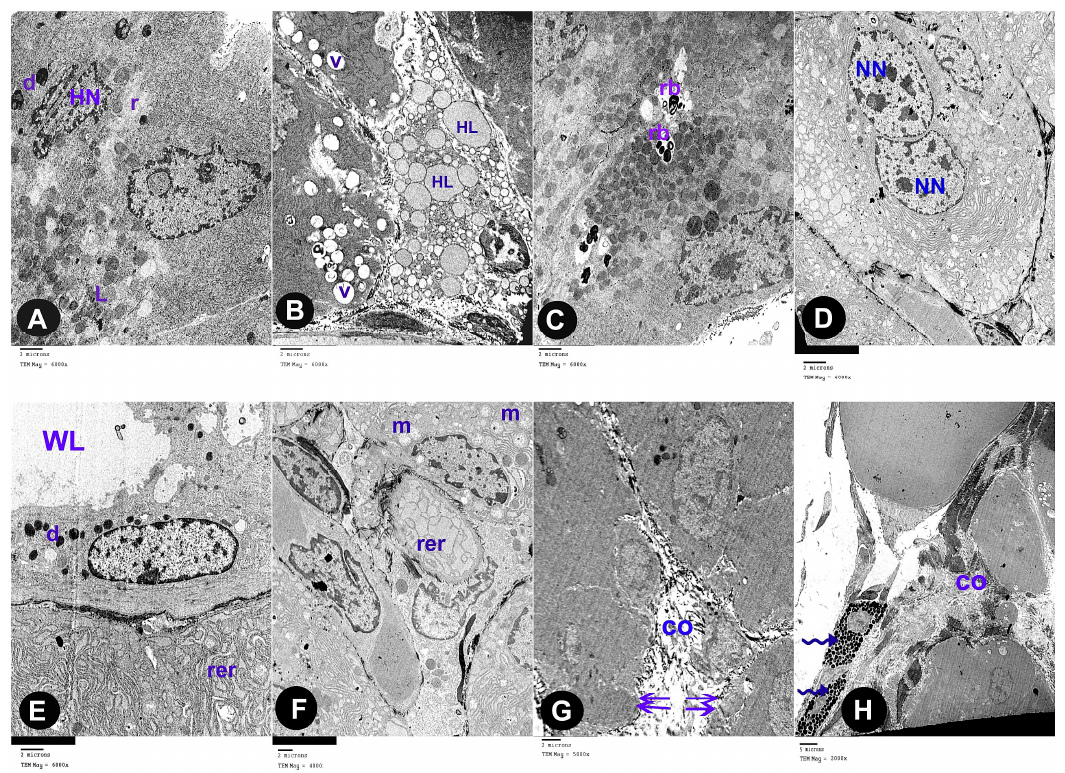
Figure 4. Electron microscope sections in parotid tissue of albino rats of the Alternariol group: ( A ) acinar cells with rarified cytoplasm (r). Heterochromatic irregular shrunken nuclei (HN). Electron dense secretory granules (d), electron lucent granules (L). ( B ) Huge granules (HL), cytoplasmic vacuoles (V). ( C ) Some cells contain residual bodies (rb). ( D ) Other cells contain double nuclei (NN). ( E ) Dilated, irregular, rough endoplasmic reticulum (rer), electron dense secretory granules (d) and wide acinar lumen (WL). ( F ) Deformed mitochondria (m) and dilated, irregular, rough endoplasmic reticulum (rer). ( G ) Widening of intercellular spaces (double arrows) with many collagen fibers (co). ( H ) Mast cells with many secretory granules (zigzag arrow) and collagen fibers